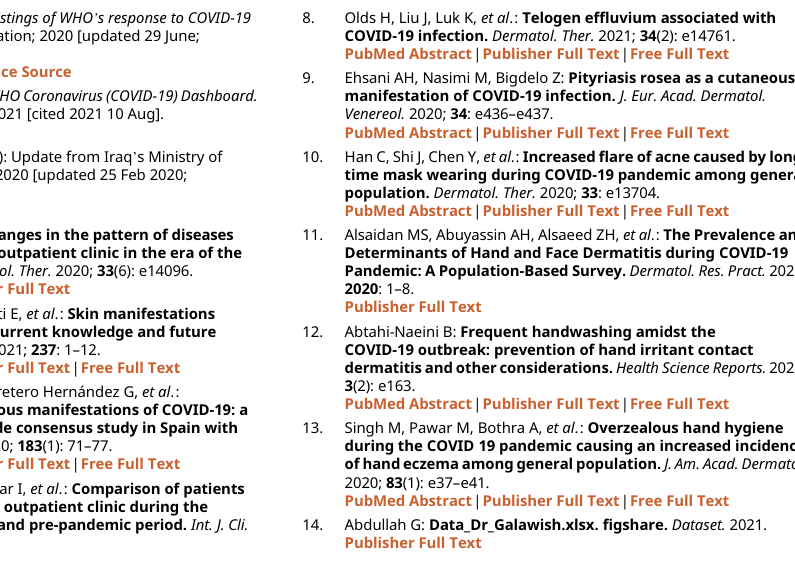
Data are available under the terms of the Creative Commons Attribution 4.0 International license (CC-BY 4.0).